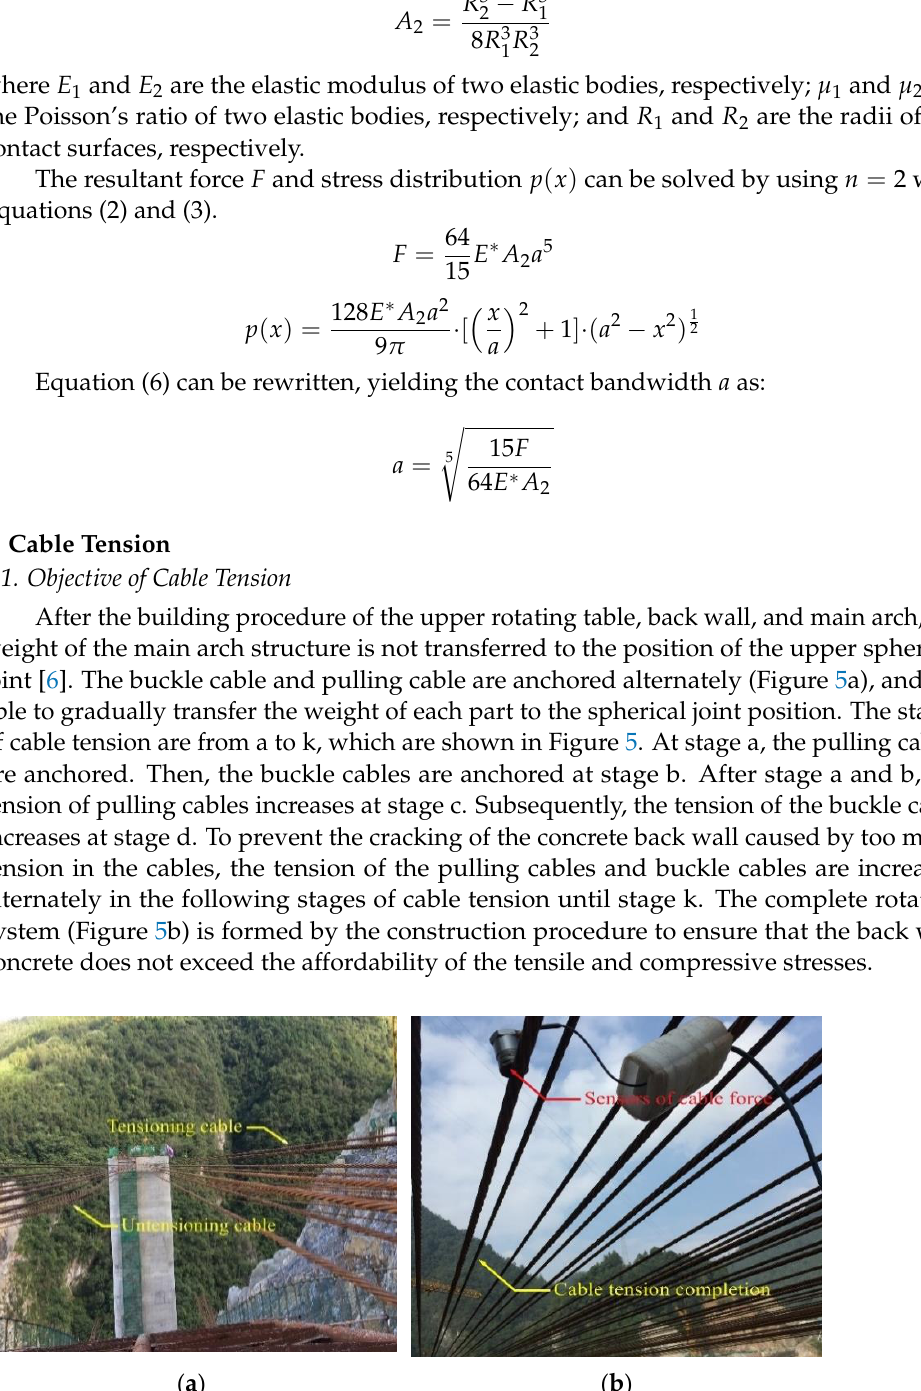
Figure 6. Vertical displacement monitoring position. Table 1. Vertical displacement of the cable tension stage. Stage of Cable Tension